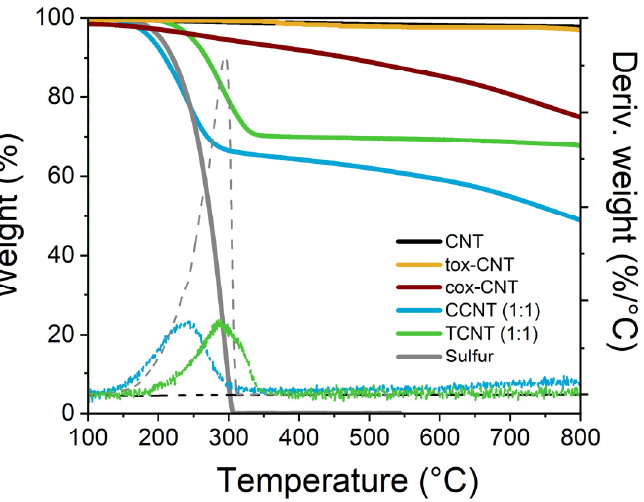
Figure 5. Thermogravimetric analysis (TGA) and derivative thermogravimetric analysis (DTGA) curves of pristine CNTs, chemically oxidized CNTs (cox-CNTs), thermal oxidized CNTs (tox-CNTs), reference sample of CCNT, reference sample of TCNT, and elemental sulfur. The reference samples of functionalized CNTs (independently of the applied functionalization process) correspond to the reactions in which the S/CNT ratio was 1:1 in weight.